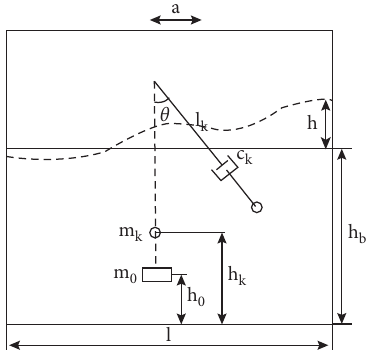
Figure 9: Schematic diagram of the liquid sloshing equipment model.